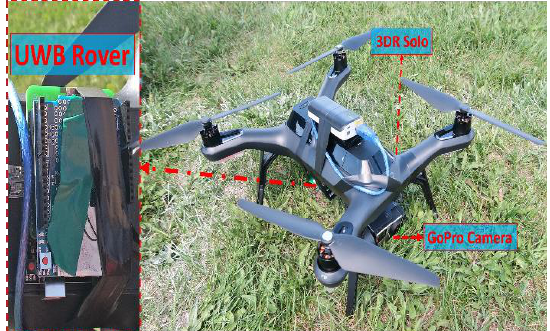
Figure 2. 3DR Quadcopter with UWB system and camera attached to